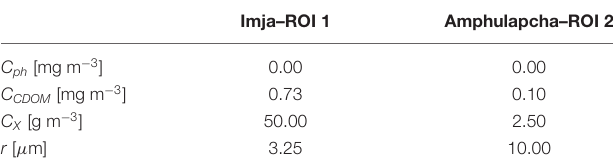
TABLE 6 | MCMC outputs for example 1.